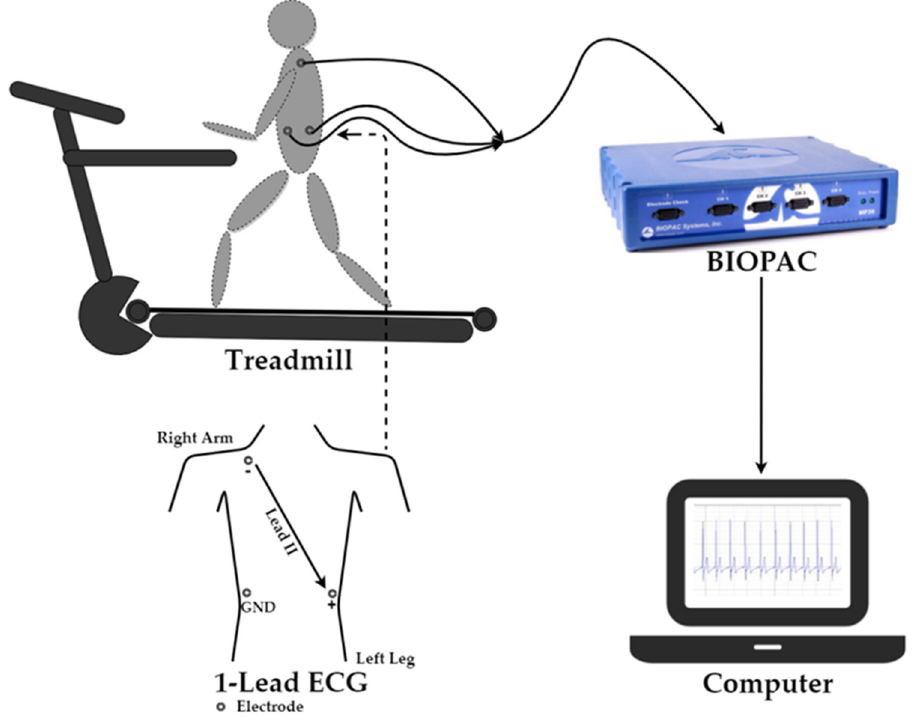
Figure 3. Scheme of the treadmill ECG monitoring system for EST.